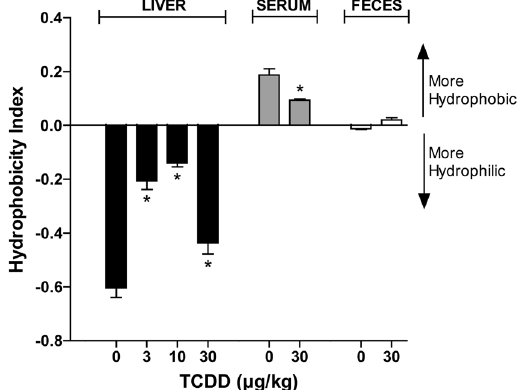
Figure 5. Hydrophobicity indices (HIx) of bile acid mixtures in the liver, serum, and feces of male C57BL/6 mice orally gavaged with sesame oil vehicle or TCDD (3–30 µ g/kg TCDD) every 4 days for 28 days. Bile acid toxicity is positively associated with the degree of hydrophobicity, where increasingly positive and negative HIx values indicate greater hydrophobicity and hydrophilicity, respectively. Bars represent the average ± standard error of the mean for at least 4 biological replicates for liver and serum, or 2 pooled samples for feces. Statistical significance ( * p ≤ 0.05) was determined using one-way ANOVA analysis followed by Dunnett’s post-hoc test (liver) or a Student’s t-test (serum) performed in SAS 9.3. Fecal pellets were collected from two cages of co- housed mice for each treatment group (n = 2) and therefore statistical analysis was not